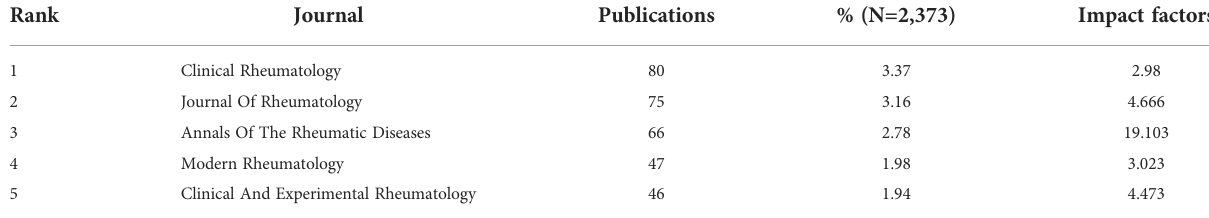
TABLE 3 Top 5 journals with the largest number of articles from 1921 to